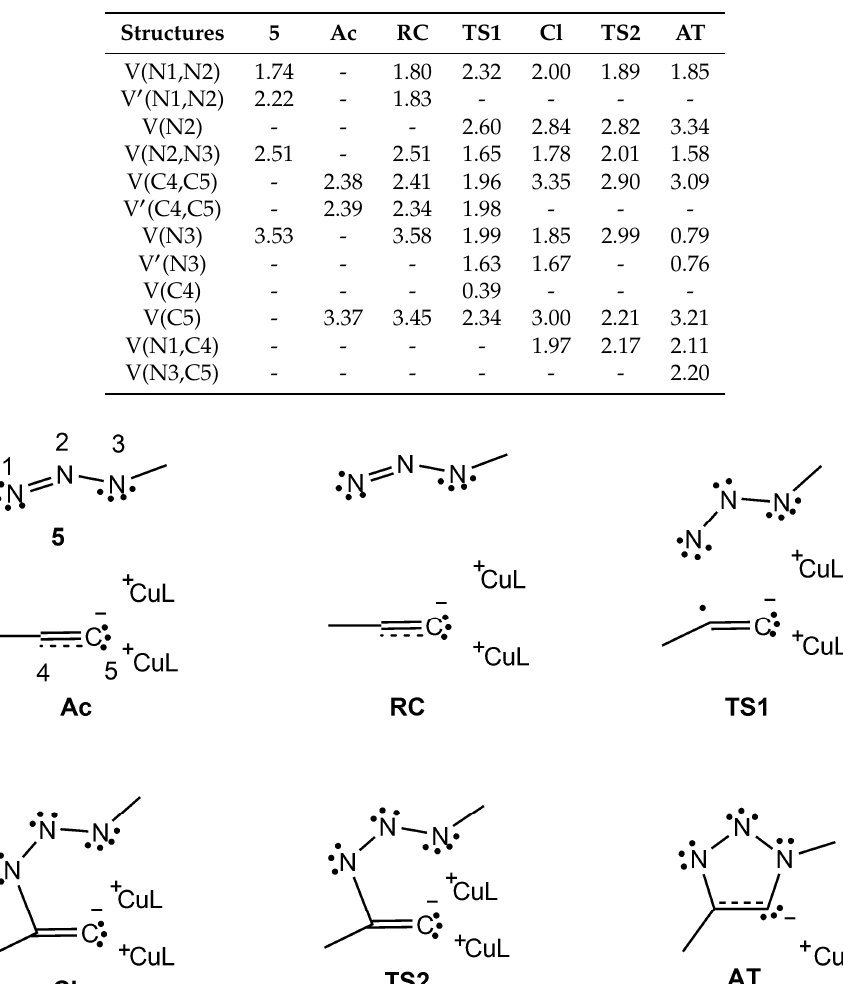
Table 6. ELF valence basin populations in the average number of electrons (e) of the intermediates involved in the CuAAC reaction of Ac with 5 .